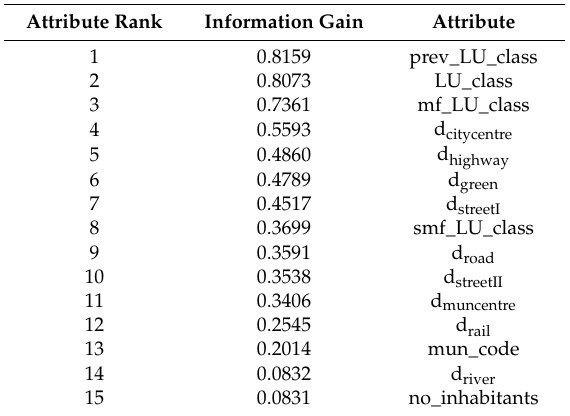
Table 3. Top ranked attributes based on the Info Gain (IG) method.